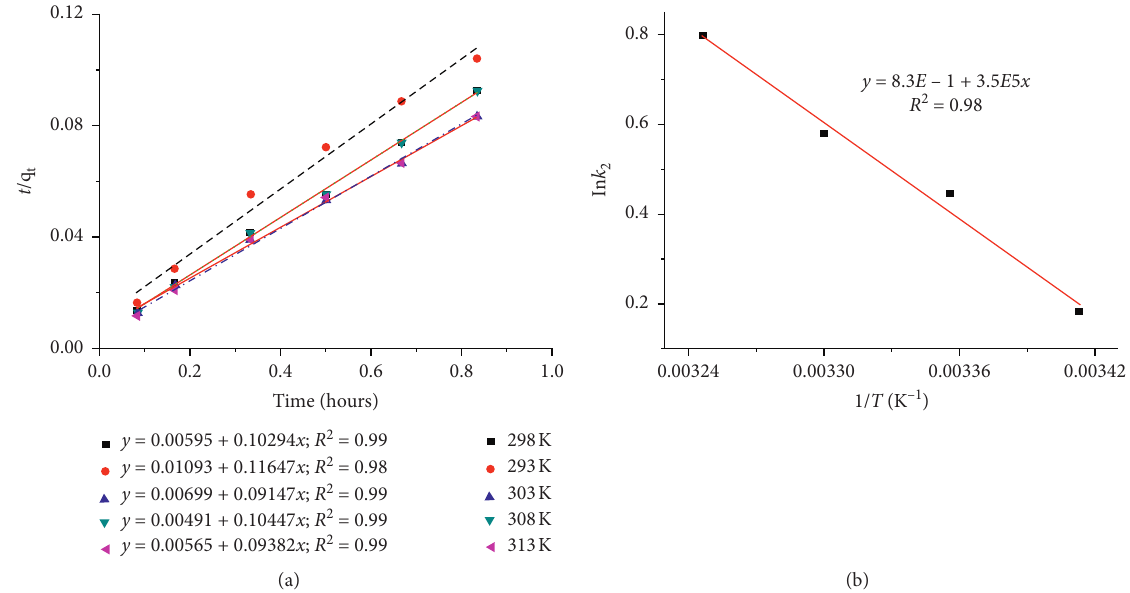
Figure 19: (a) Pseudo-second-order kinetics of Cr(VI) sorption onto 0.02g of Fe concentration of 10ppm Cr(VI) solution used. (b) Van’t Hoff plot for determination of activation energy in the adsorption mechanisms of Fe 3 O 4 @SiO 2 @LEuH@PW 10 with CrO 42 −